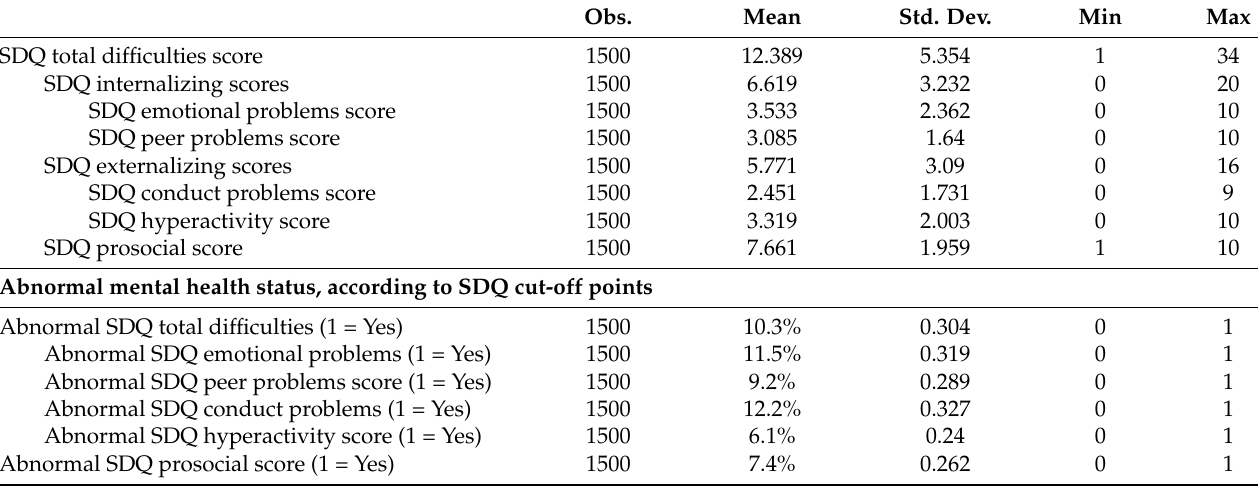
Table 2. Summary statistics of